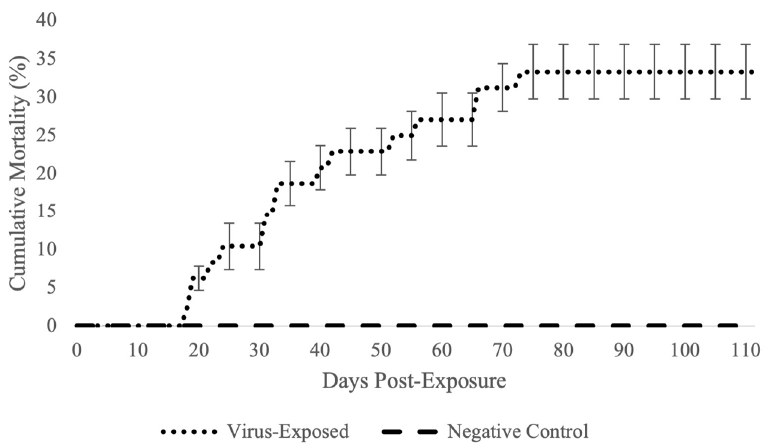
Figure 8. Cumulative percent mortality in juvenile Great Lakes lake sturgeon experimentally im- mersed in a suspension of the newly isolated lake sturgeon herpesvirus (1.28 × 10 6 TCID 50 /mL). Error bars indicate standard error for every ten days post-infection.